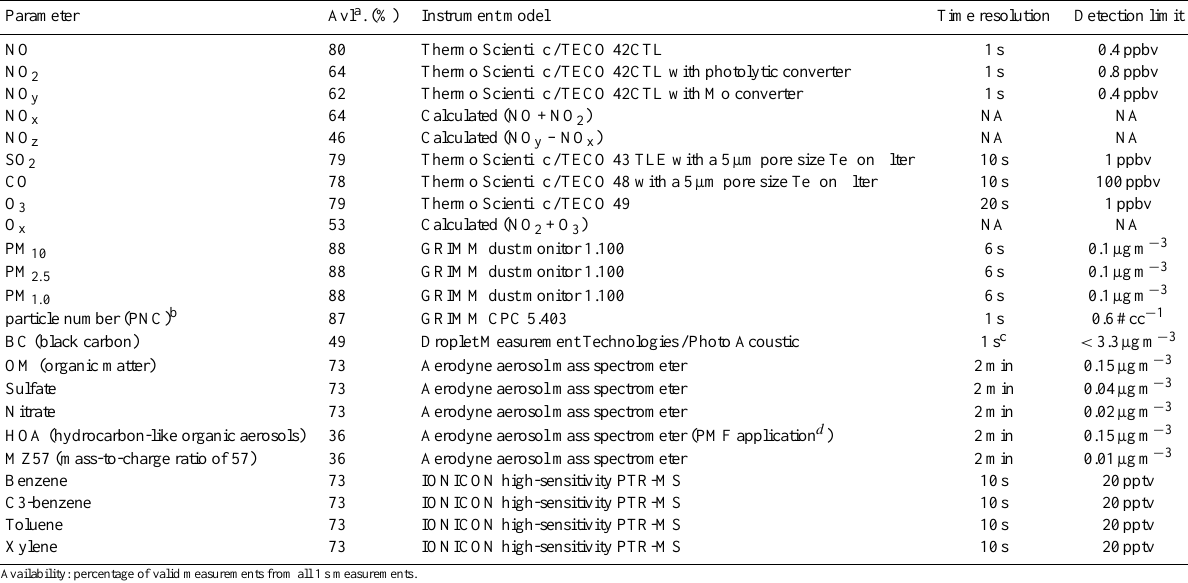
Table 1. List of pollutants measured by CRUISER or derived from CRUISER measurements and the methods employed.